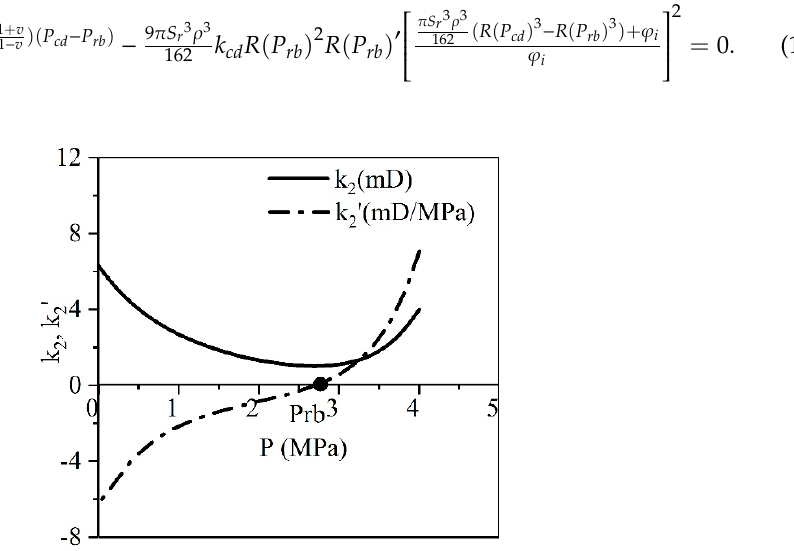
Figure 4. Permeability dynamic change in the coalbed methane (CBM) desorption stage.